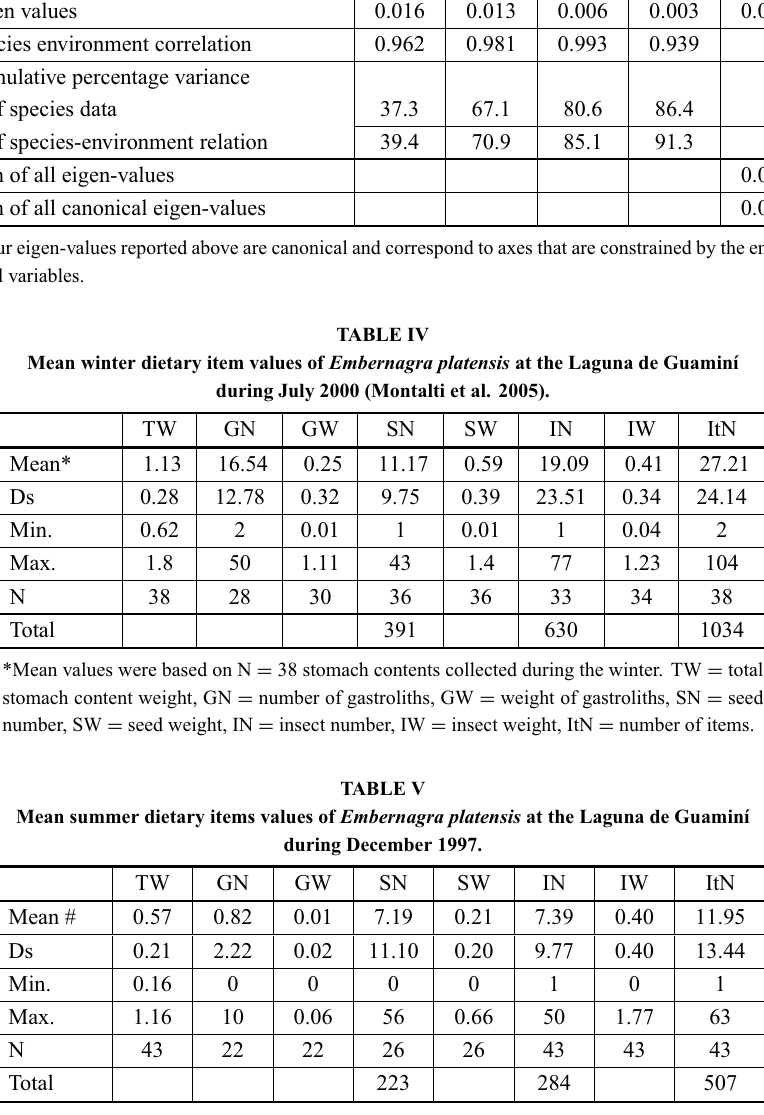
CCA analysis summarizing the correlation among variables and the information explained by axes. Axes 1